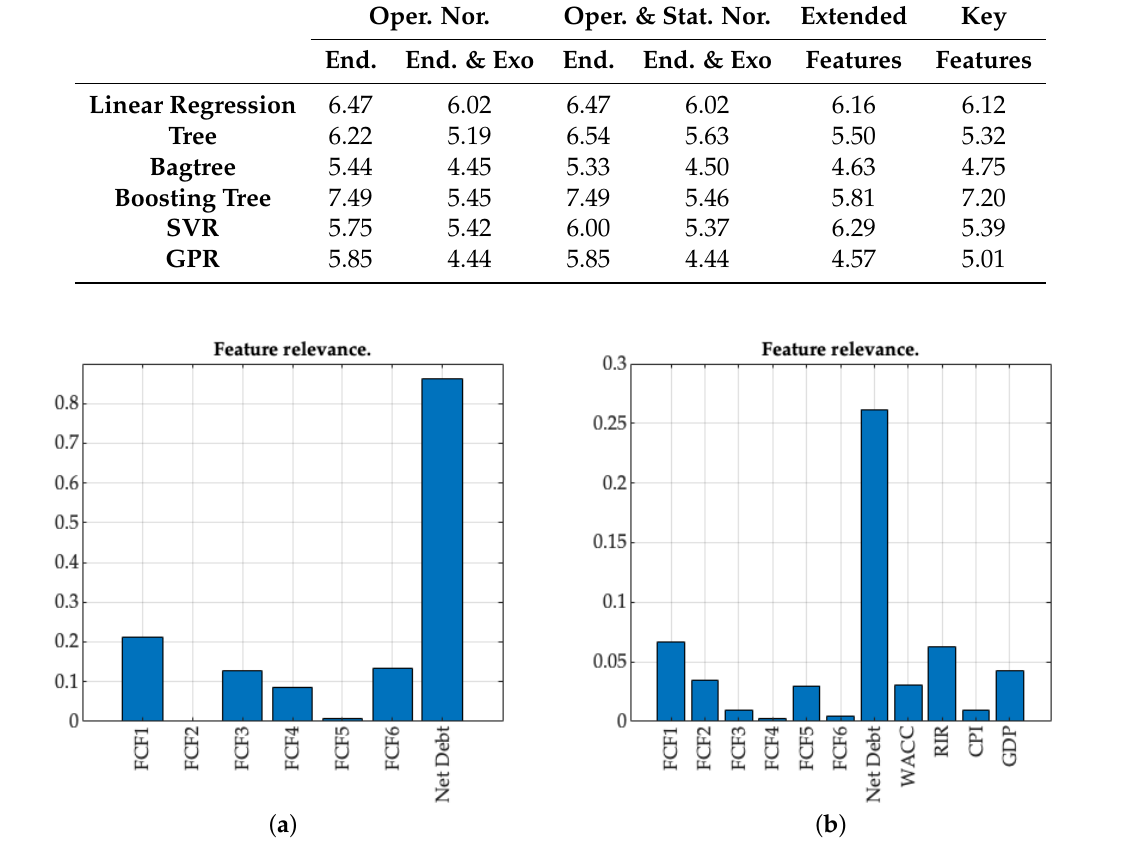
Figure 2. Feature relevance based on decision trees for normalized EV estimation when using: ( a ) Only endogenous variables; ( b ) Both endogenous and exogenous